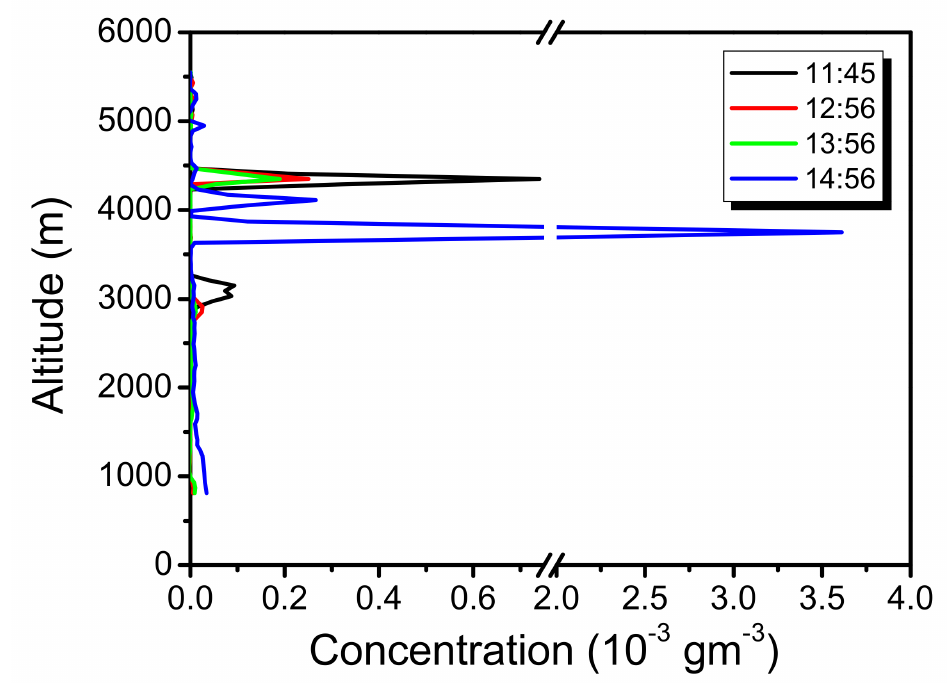
Figure 8. Lidar ash mass concentration profiles in 10 − 3 g / m 3 at 11:45, 12:56, 13:56 and 14:56. The error in the ash mass concentration is about 60%.